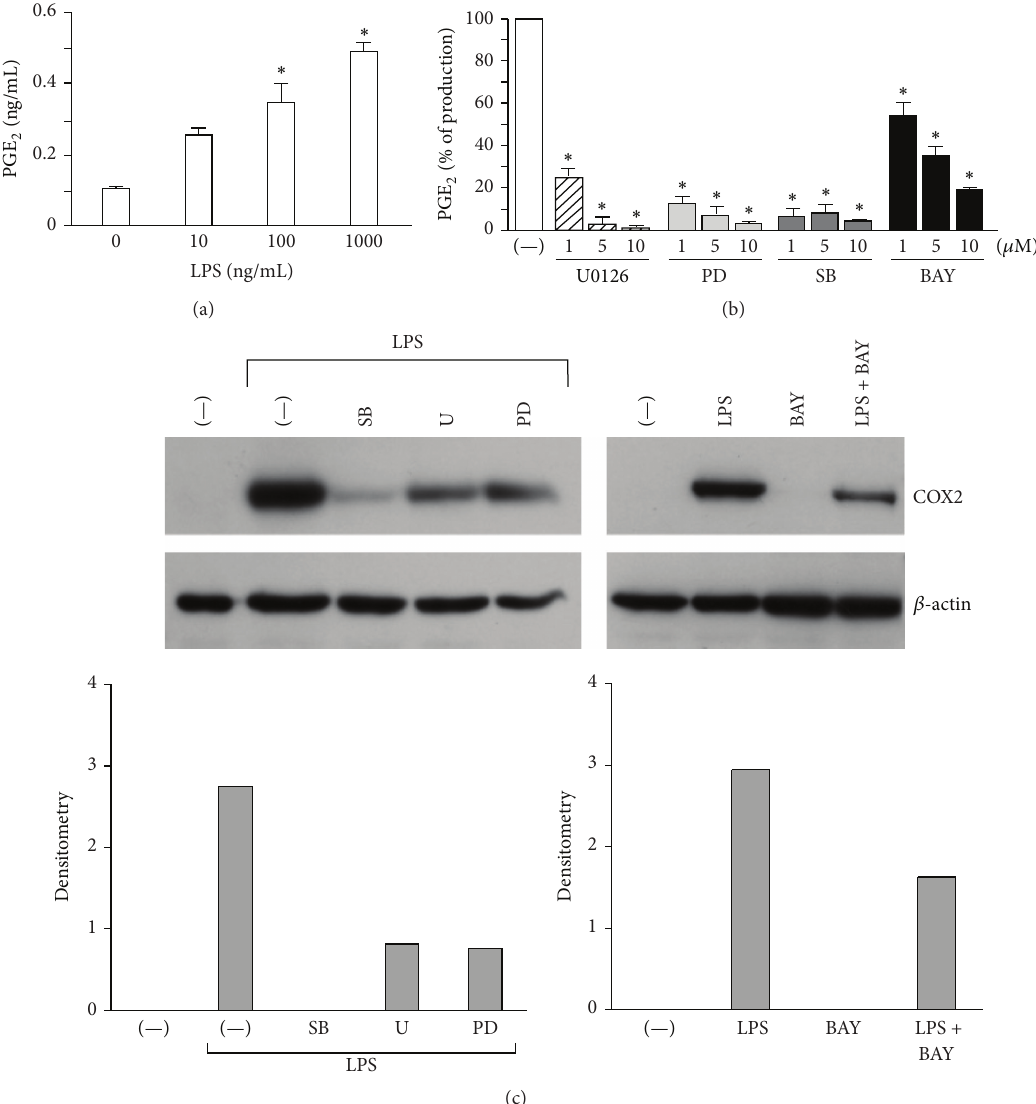
Figure 2: The release of PGE 2 by DCs depends on the activation of the MAPK and NF- 𝜅 B pathways. (a) DCs were stimulated with increasing concentrations of LPS for 24 h and PGE 2 production was quantified by EIA. Data are expressed as mean ± SEM ( 𝑛 = 3 ); ∗ 𝑃 < 0.05 by one-way ANOVA with Dunnett’s post hoc test. (b) DCs were pretreated for 1h with the indicated doses of U0126, PD98059, SB203580, or BAY-11-7082 and then stimulated with LPS (100ng/mL) for 24h. The production of PGE 2 was evaluated in cell-free supernatants by EIA. Results are expressed as mean ± SEM ( 𝑛 = 3 ); ∗ 𝑃 < 0.05 by one-way ANOVA with Dunnett’s post hoc test. (c) DCs were treated as in (b), using 1 𝜇 M of each inhibitor. The expression of COX2 and 𝛽 -actin was determined by Western blot. One representative fluorogram out of three and its densitometric analysis are